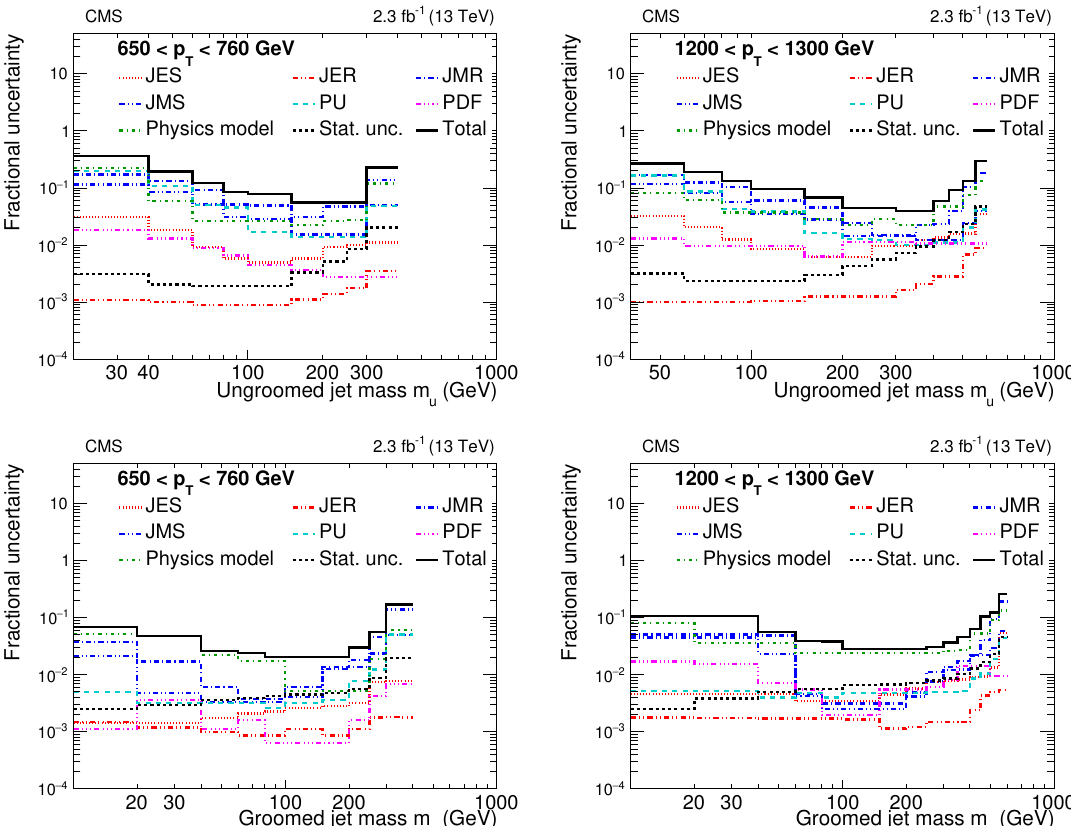
Figure 5 . Systematic uncertainties in the normalized cross section after unfolding for two p T bins before grooming (top) and after grooming (bottom). The red dotted lines show the JES uncertainties. The red dash-dot-dotted lines show the JER uncertainties. The blue dash-dotted lines show the JMR uncertainties. The blue dash-dot-dotted lines show the JMS uncertainties. The cyan dashed lines show the PU uncertainties. The orange dash-dotted lines show the luminosity uncertainties. The magenta dash-dot-dot-dotted lines show the PDF uncertainties. The green dash- dotted lines show the physics model uncertainties. The black short-dashed lines show the statistical